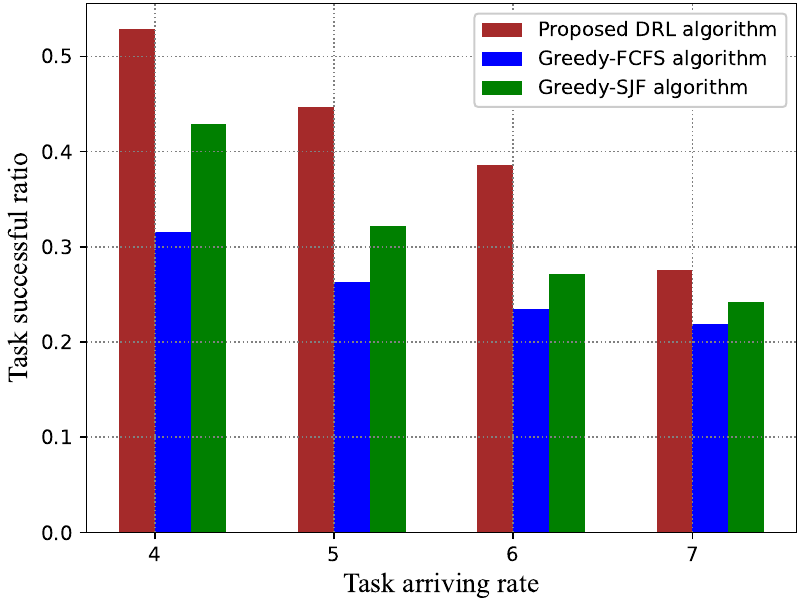
Figure 9. Success ratio versus task arriving